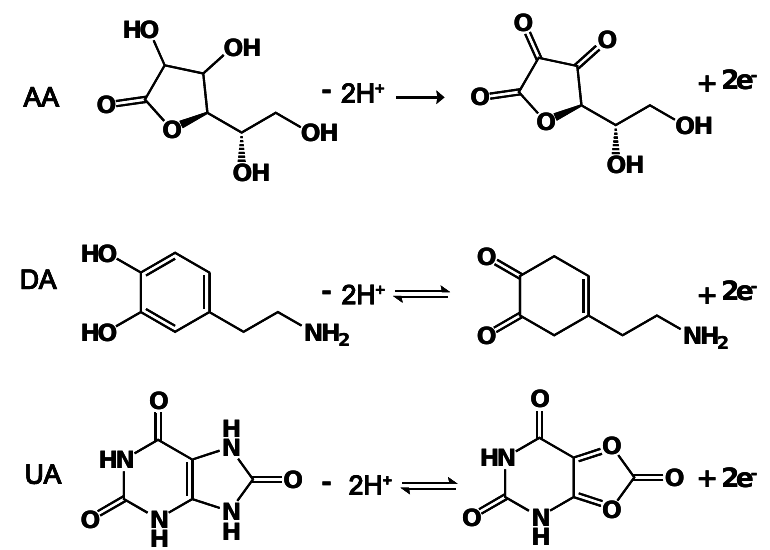
7 of 11 Figure 2. ( A ) Differential pulse voltammograms (DPVs) at Au/HGO/GCE and 3D